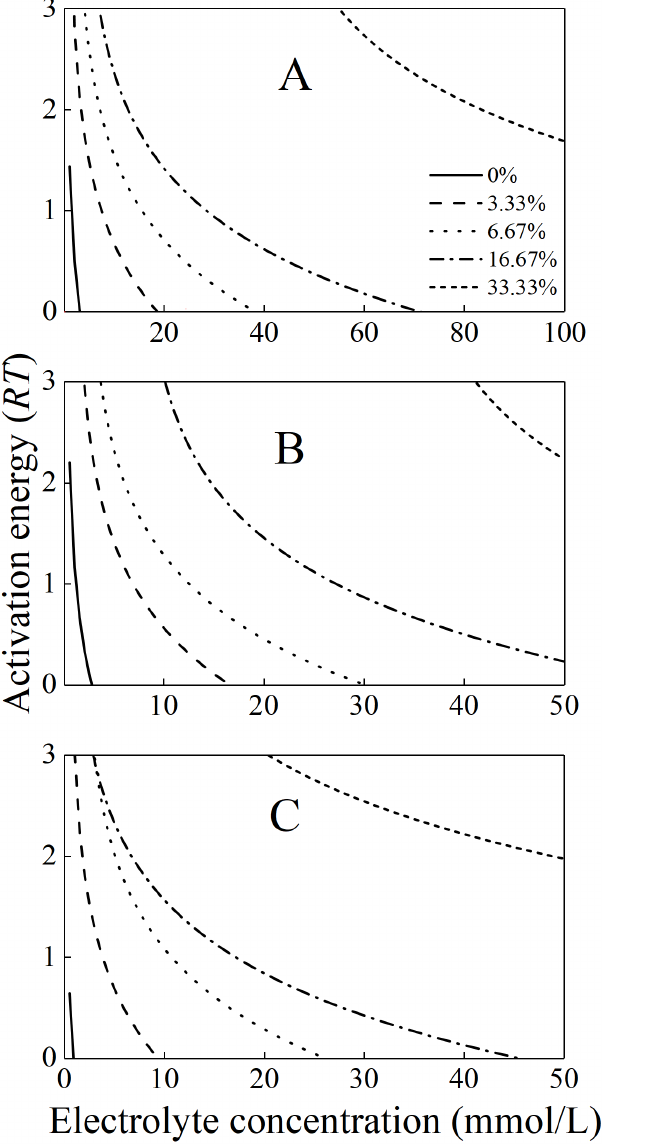
Figure 4 The activation energies for the aggregation of the mixture colloids with different bacteria Full-size DOI: